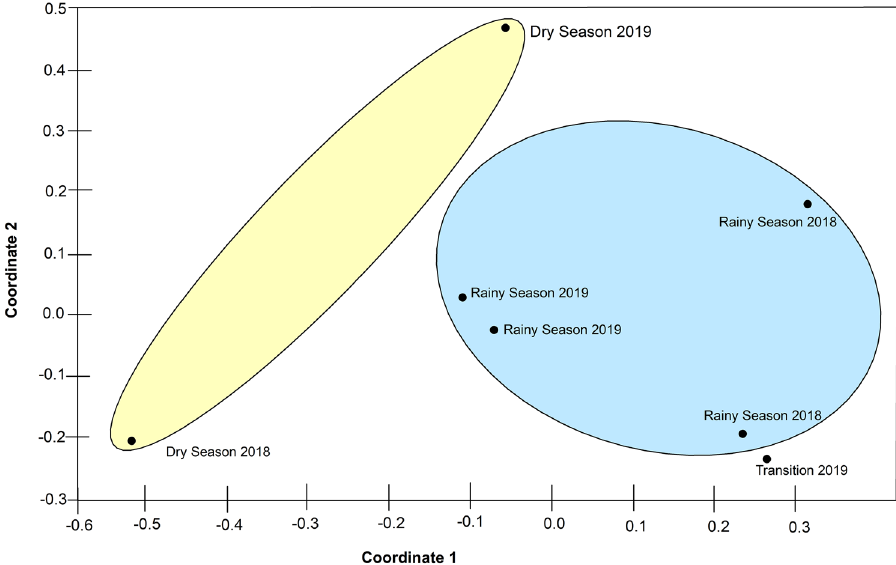
Figure 4. Non-metric multidimensional scaling (NMDS) using Morisita similarity index for ordination, depicting two distinct groups formed by collections from the wet and dry seasons (stress =